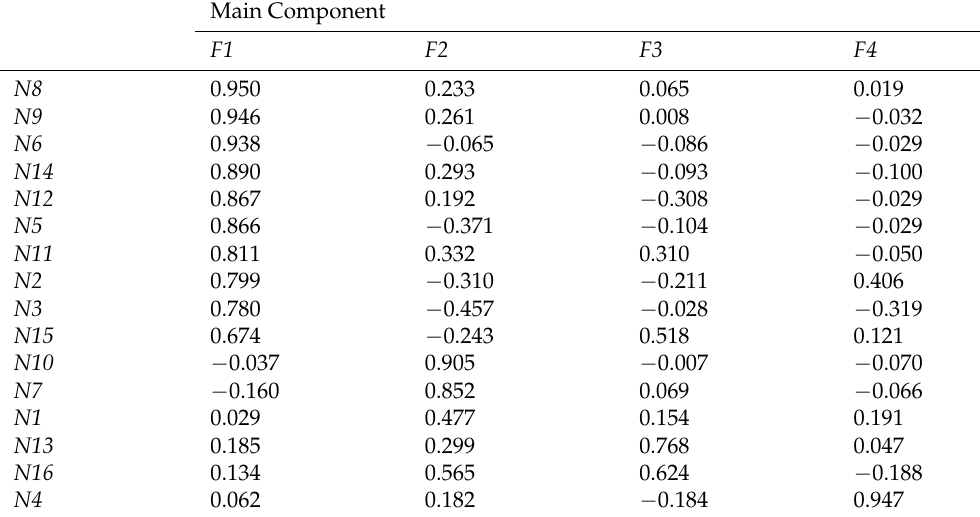
Table 10. Factor load matrix (component